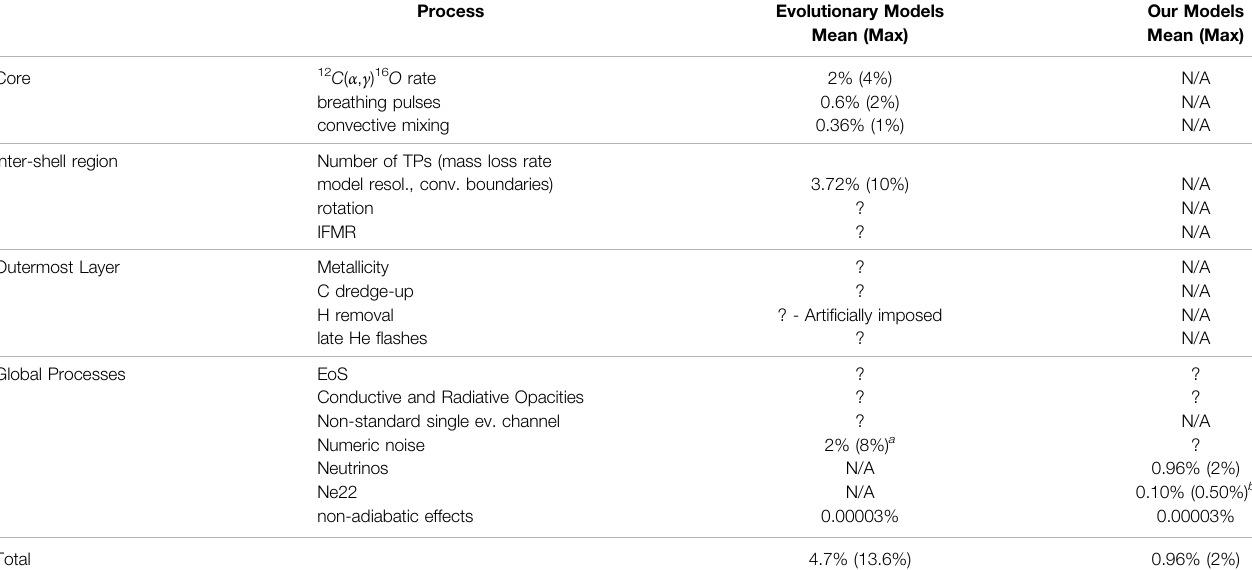
TABLE 2 | List of potential contributions to the error budget that result from global processes and from speci fi c prescriptions affecting the various layers of a white dwarf. These are estimated for evolutionarymodels (before last column) and for ourstatic models (last column). We note that various potentialsources ofuncertainties thatcan affect the models have never been evaluated and their magnitude is unknown (those are indicated by question marks). We estimate the overall effect of TPs, overshooting prescriptions,anddifferent 12 C ( α , γ ) 16 O reaction rateswiththechemicalpro fi les retrievedfromDeGerónimo etal.(2017).Thelastlinesums-upalleffectsofthelistedexternal uncertainties in both cases, when